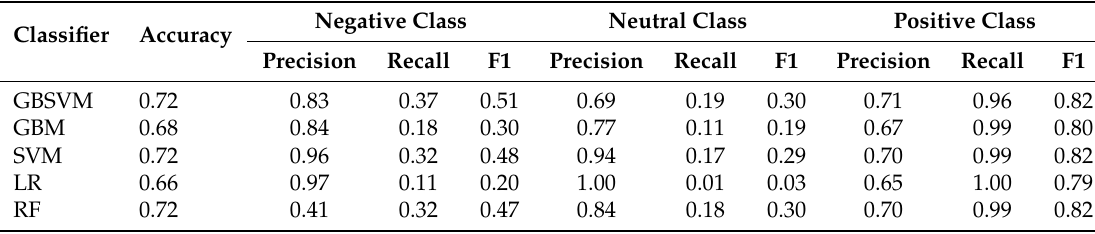
Table 6. Accuracy of classifiers using TF-IDF (Tri-gram)